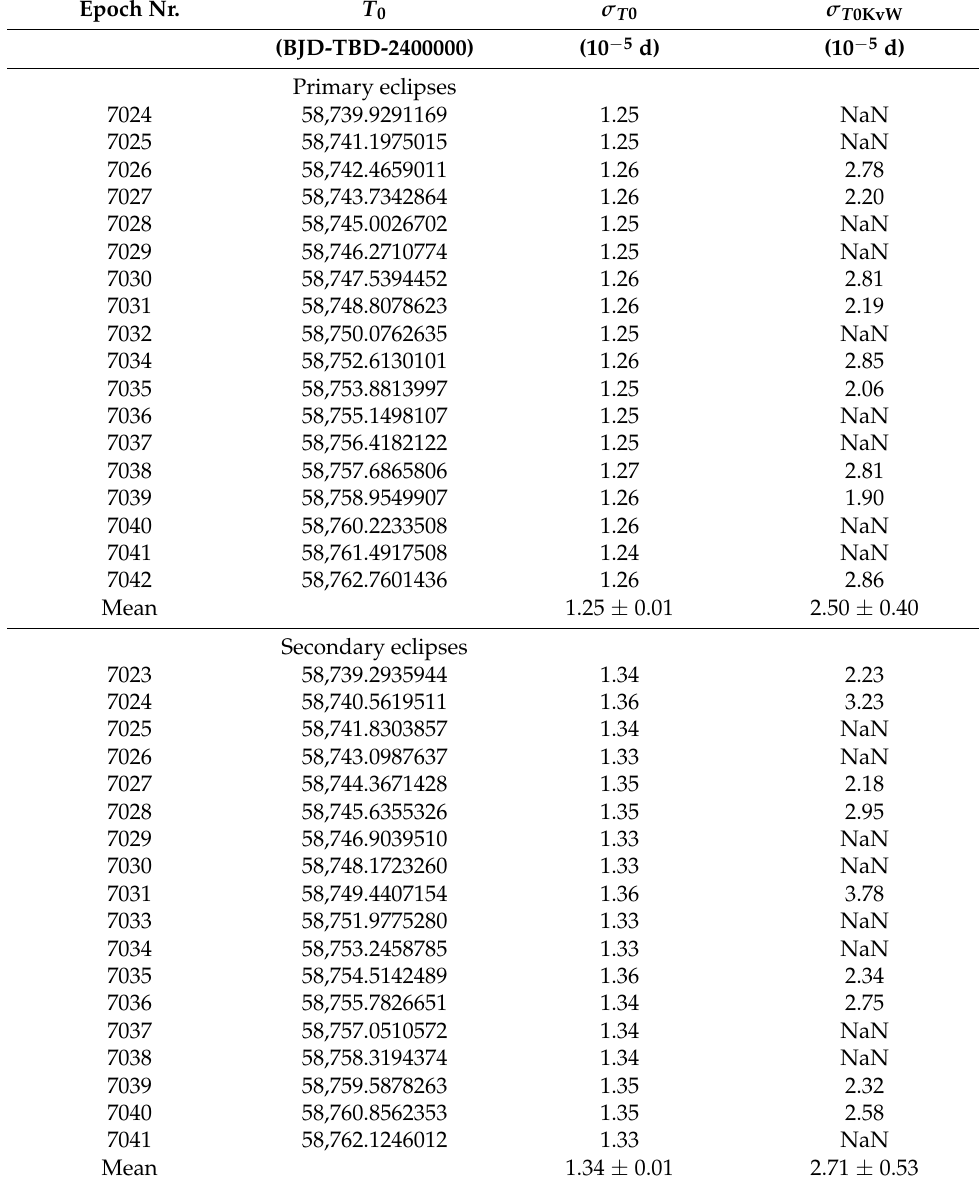
Table 1. CM Dra eclipse minimum times from the KvW method with five folds, with timing errors from the revised error estimate ( σ T 0 ) and from KvW’s original formula ( σ T 0KvW ), from TESS Sector 26 observations. Epoch numbers are relative to BJD 49,830.757712 for primary eclipses and BJD 2,549,831.390742 for secondary eclipses. Epoch